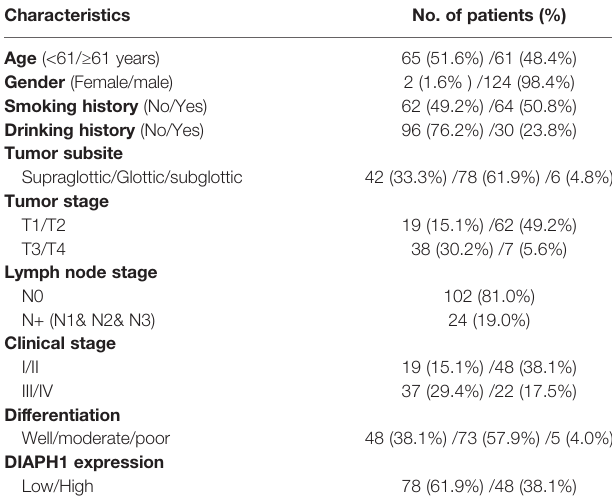
TABLE 1 | The demographics and clinical characteristics of 126 LSCC